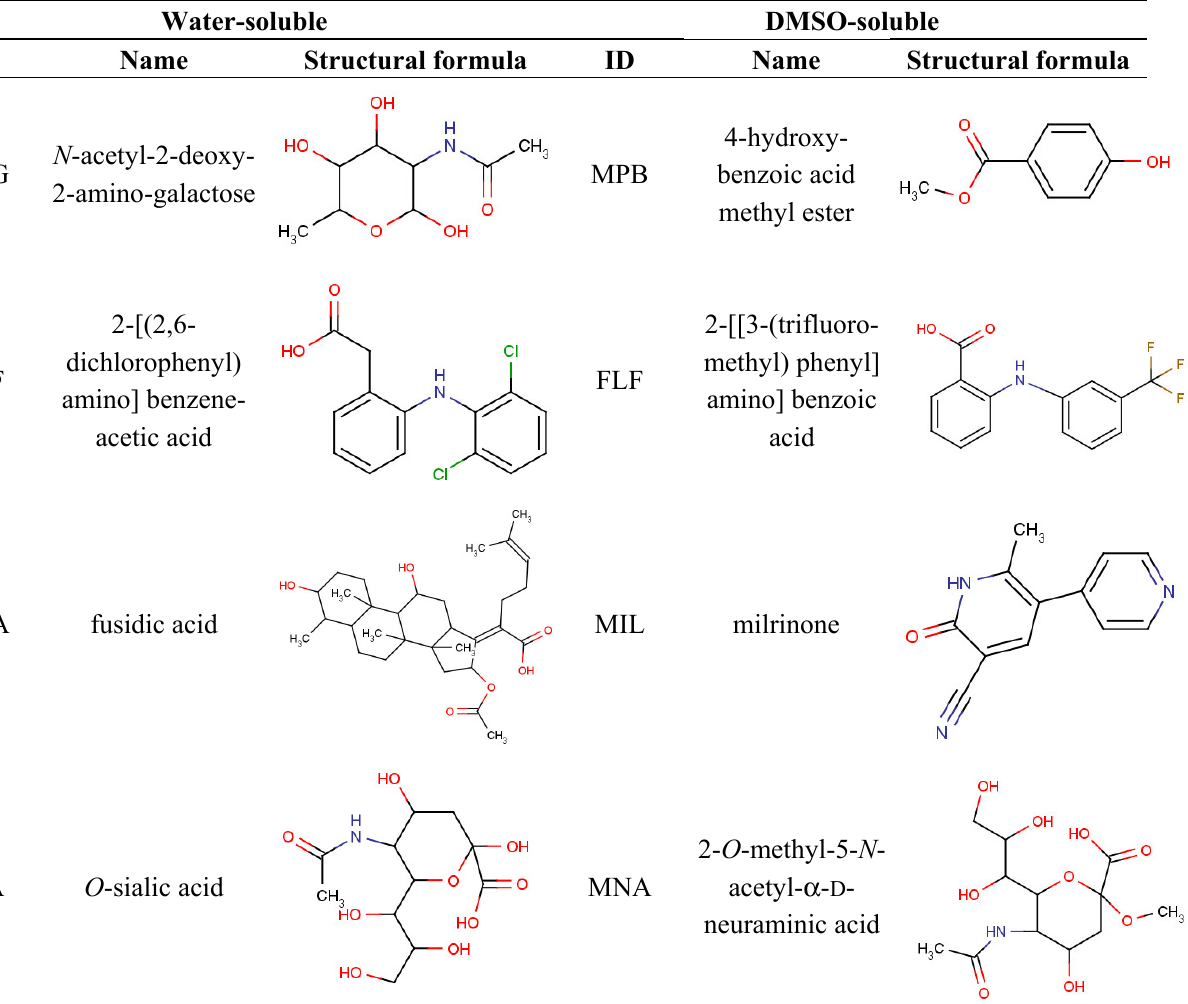
Table 2. Small compounds used in this